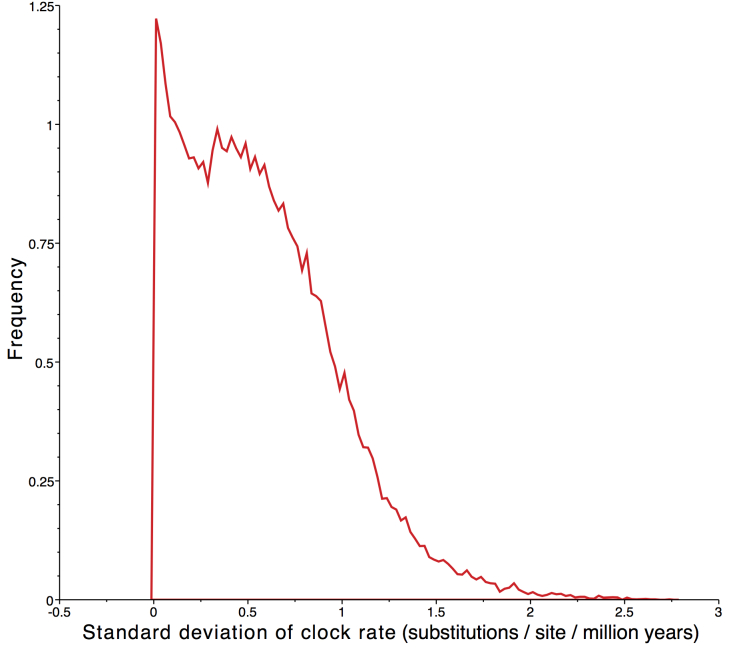
Includes data from ten combined runs (twenty million generations sampled every two thousand trees) using a relaxed molecular clock model. Units for the clock rate are in substitutions per site per million years. The distribution strongly abuts zero, indicating support for a strict molecular clock 51.